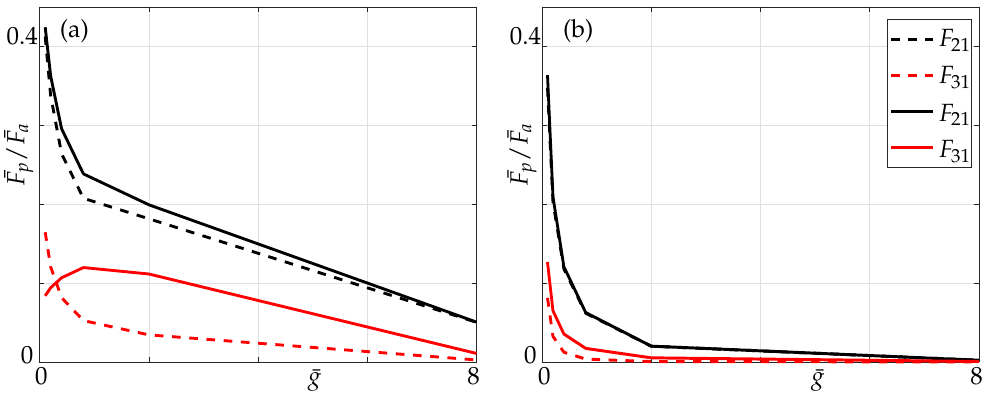
Figure 11. Coupling ratios of the passive beam with respect to active beam over a range of gaps in a three-beam array for the 1–0–0 configuration at ( a ) Re = 0.1 and ( b ) Re = 100; nearest neighbours only (dashed lines) and all members (solid lines).